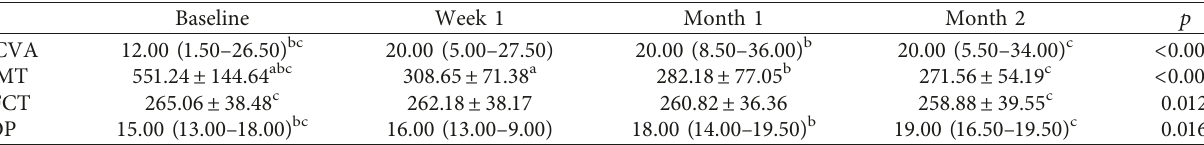
Table 1: Comparisons of different clinical parameters in patients with macular edema secondary to retinal vein occlusion, at baseline (before injection) and 1week, 1month, and 2months after injection.